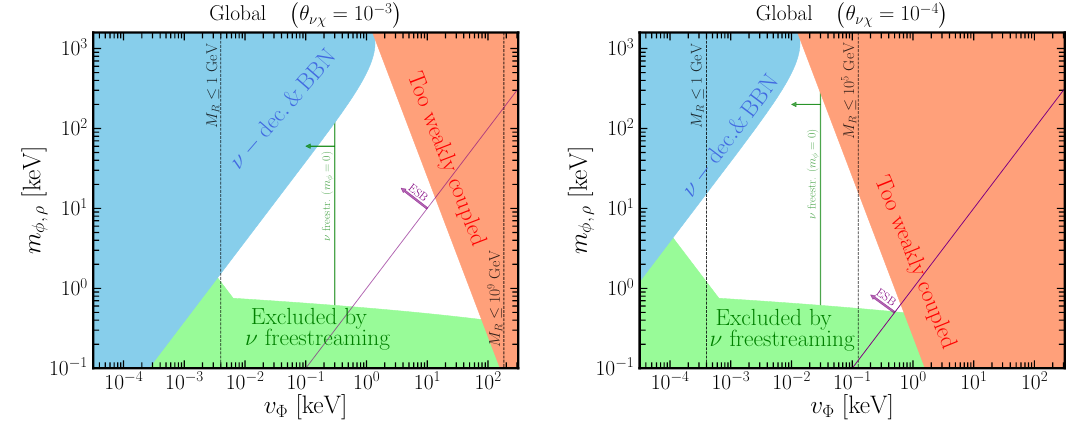
Figure 3 . Regions of the parameter space of the global U(1) X model excluded by several cosmological bounds for a value of the mixing between active and massless sterile neutrinos, θ = 10 − 3 (left) and νχ 10 − 4 (right). The white region is allowed. Vertical dotted black lines correspond to the maximum M R value in GeV given by the requirement of perturbativity for Y , see eq. (5.3), or by the requirement Φ of λ 10 − 6 when stronger, see eq. (5.5). The purple line indicates the region where m , H Φ ≤ φ > v Φ where the explicit breaking of the U(1) symmetry by the scalar mass would dominate over the X spontaneous breaking. The vertical green line highlights parameter space excluded from neutrino freestreaming in the specific case m = 0 . φ